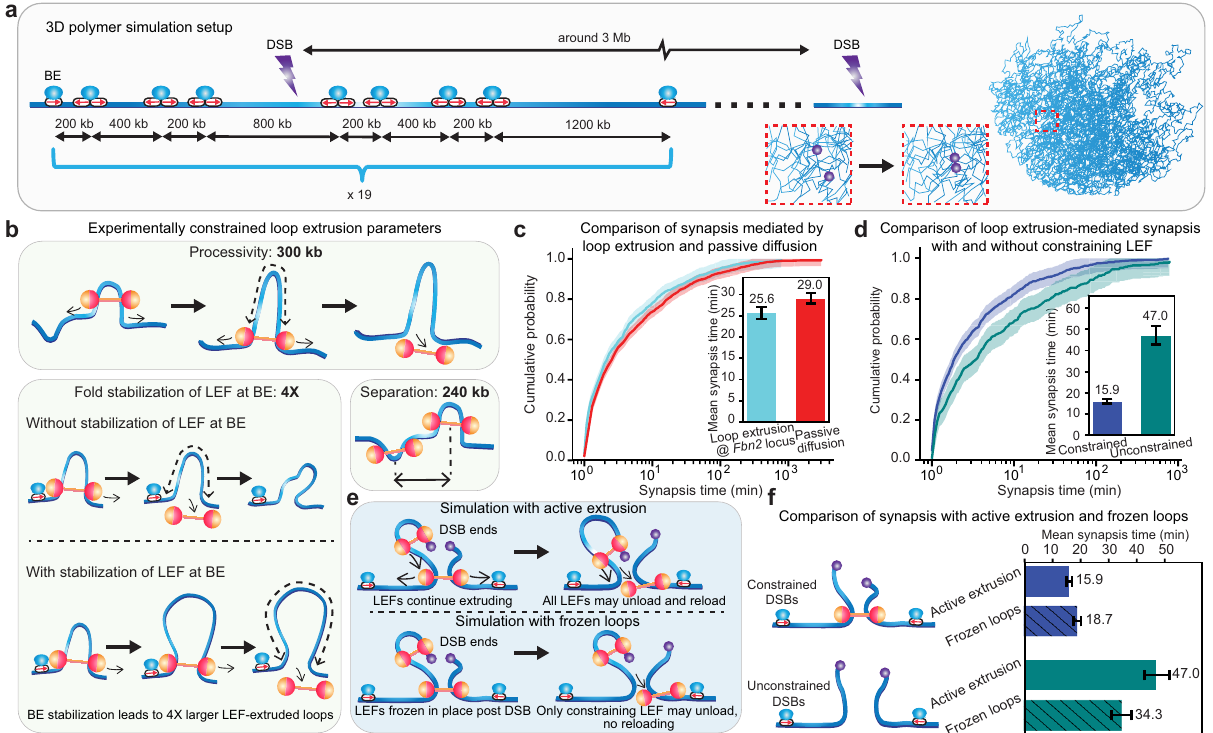
Fig. 2 | Loop extrusion achieves faster synapsis than passive diffusion alone. a Overview of 3D polymer simulation setup and representative 3D polymer con- formation. A snapshot of part of the chromosome used in 3D polymer simulations isshownontheright.Theinsetinthereddashedsquaredepictsthesynapsisoftwo DSB ends. b loop extrusion dynamic parameters estimated from the Fbn2 locus. c Improved synapsis ef fi ciency with loop extrusion compared with passive diffu- sion alone. Cumulative probabilities of synapsis time for synapsis with loop extrusion and with passive diffusion alone are calculated from 1376 and 2223 DSB events, respectively. d Higher synapsisef fi ciencyat DSBs constrained by LEFs (941 events) than unconstrained DSBs (435 events). The shades in ( c , d ) around the cumulative probability curves represent the 95% con fi dence interval of the cumu- lative probability estimated with Dvoretzky – Kiefer – Wolfowitz